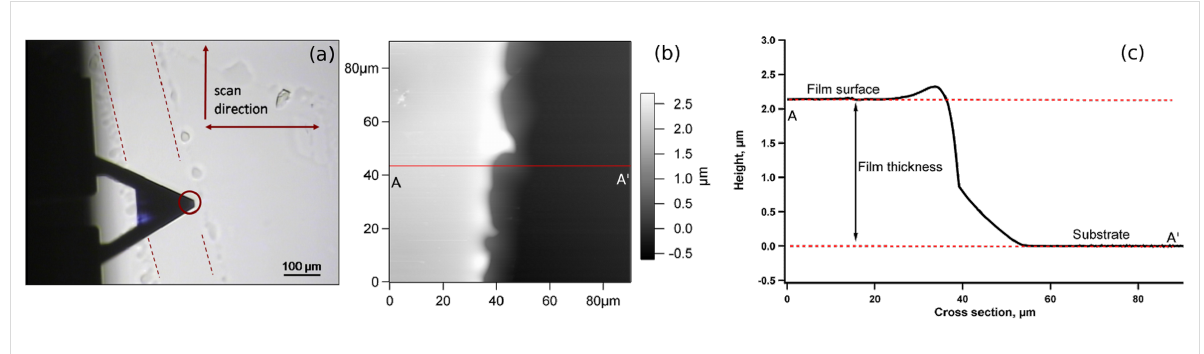
Figure 1: (a) Top camera view of the cantilever and the scratch on the film (delimited with the dashed lines). The circle points out the position of the tip. (b) 2-D AFM image of the scratch and the cross-section line (A–A ′ ). The grey scale bar shows the height. (c) Height profile through the cross- section line (A–A ′ ) for a measurement made on (PLL/HA) 36